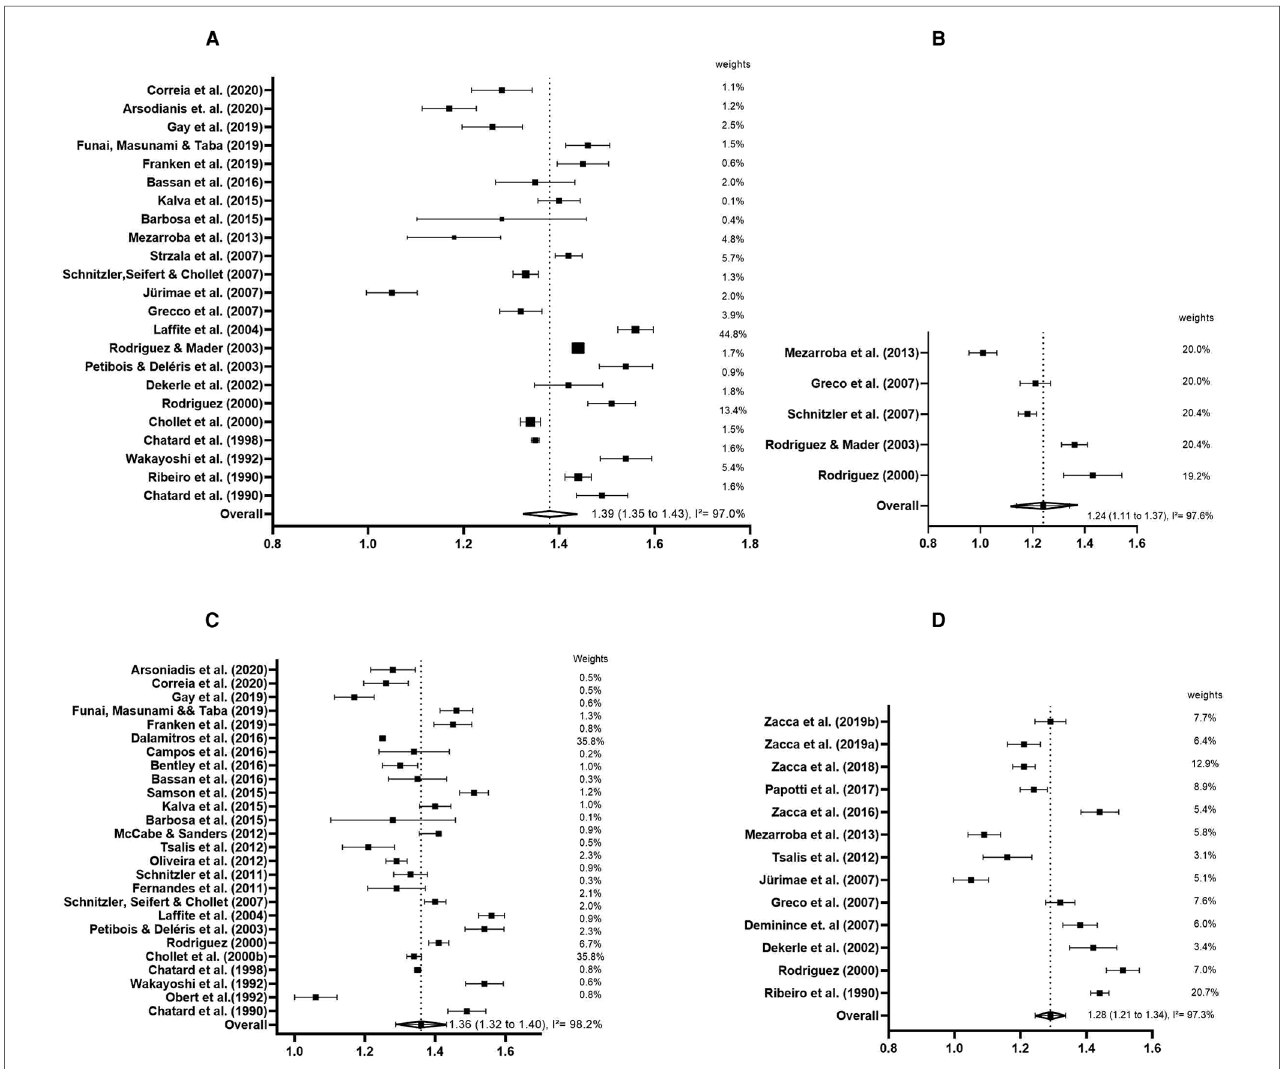
FIGURE 3 Forest plots and subgroup analyses (gender category= A : male and B : female, respectively; divided by age category= C : senior and D : junior swimmers derived from continuous random effects models depicting the swimming speed (m·s − 1 ) in 400-m front crawl test.